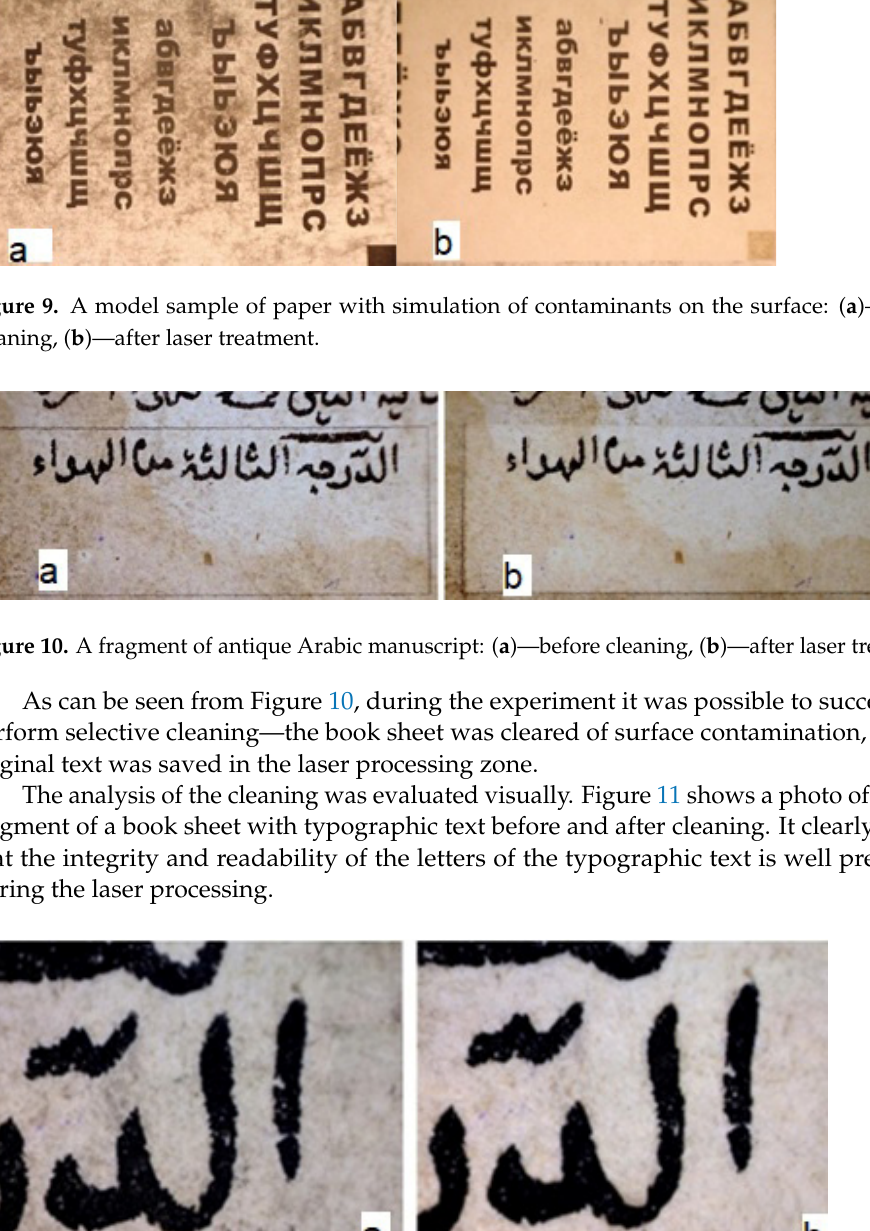
Figure 11. A small fragment of antique Arabic manuscript: ( a )—before cleaning, ( b )—after laser treatment.